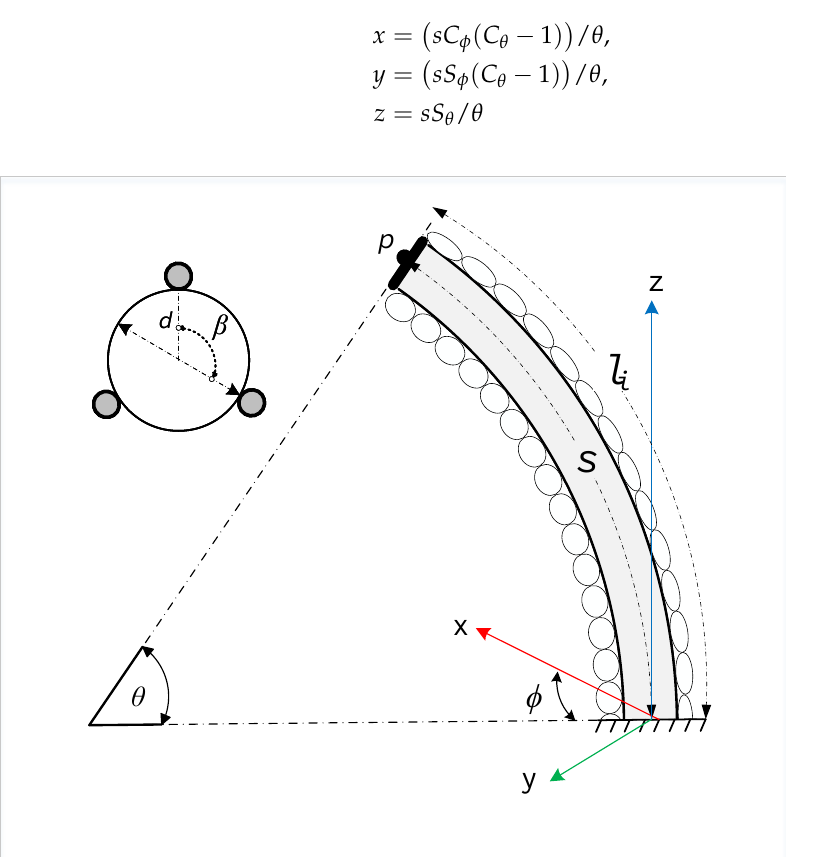
Figure 2. Schematic of vine-like growing robot and its configuration